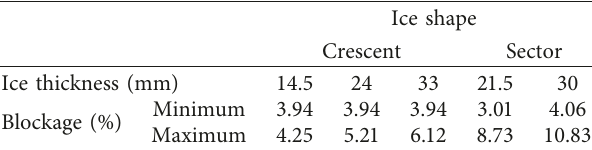
Table 3: Minimum and maximum